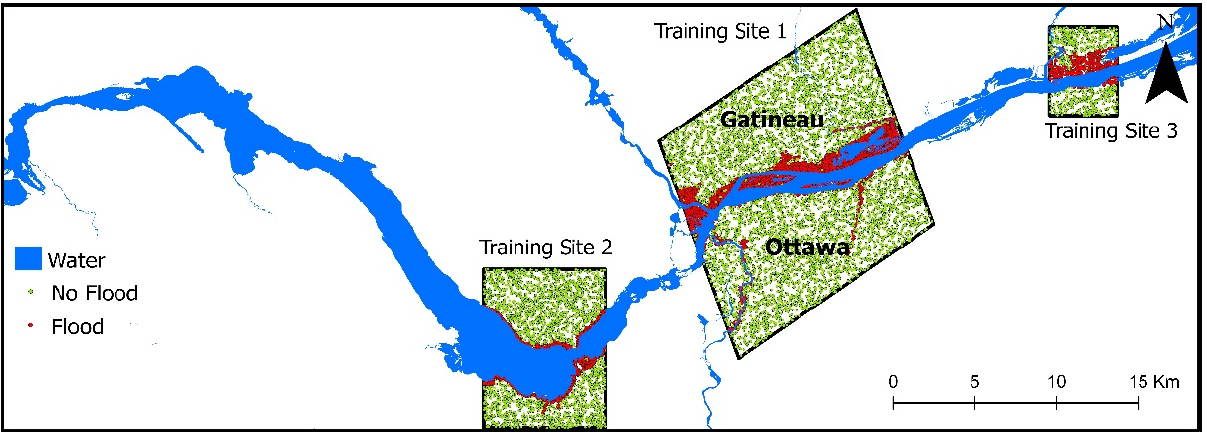
Figure 3. Multiple training sites: training site 1 (Central), training site 2 (West) and training site 3 (East) using the flood hazards maps (FDRP on the Quebec side and RVCA on the Ontario side).